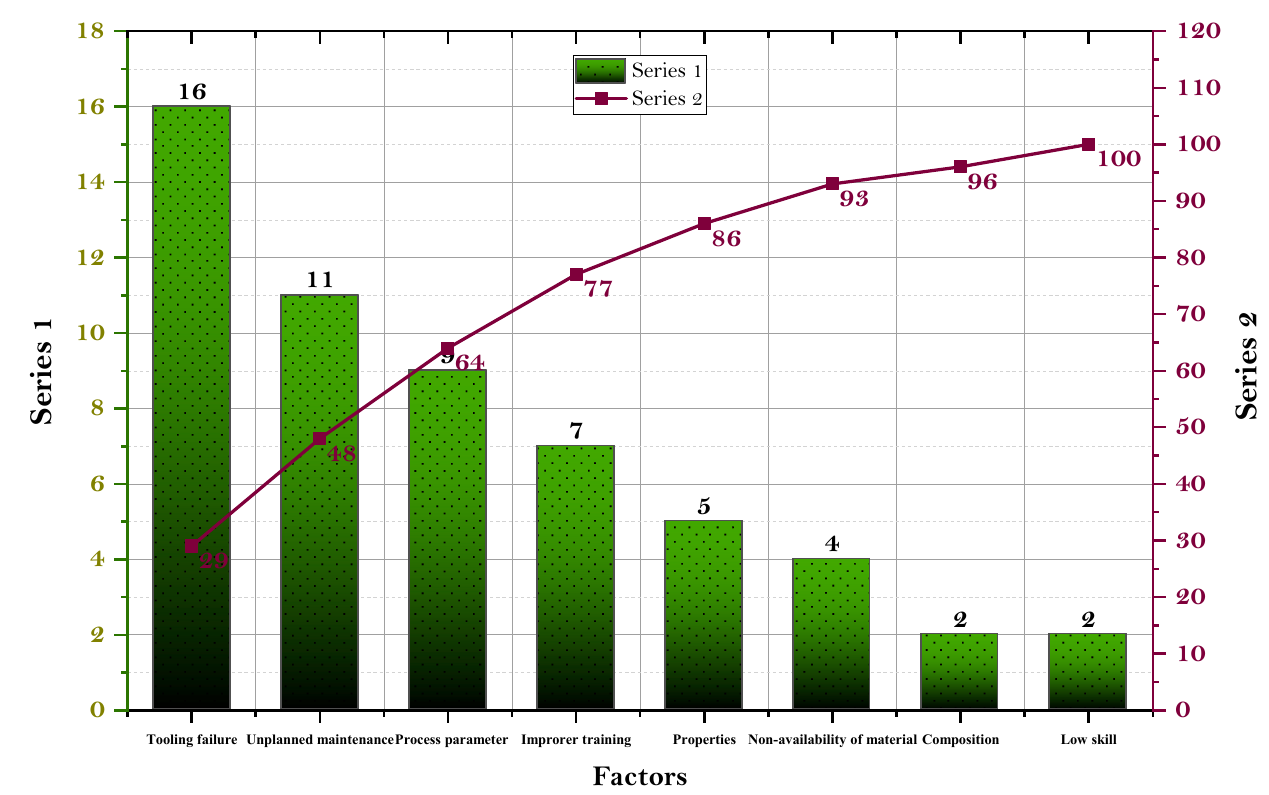
Figure 8. Second Level Pareto analysis for common causes.